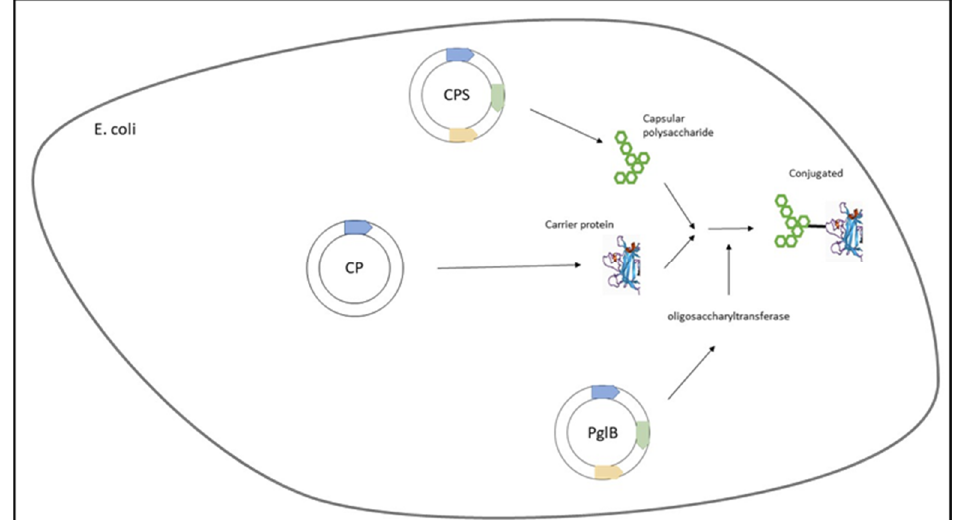
Figure 2. PGCT technology for the production of glycoconjugates. CPS, Pneumococcus capsule. CP carrier protein. PglB, glycosylation component from C. jejuni. Recombinant proteins are inserted into an inducible plasmid from the pEXT family. Conjugation was obtained by bacterial mechanical lysis and Ni affinity chromatography purification [64].